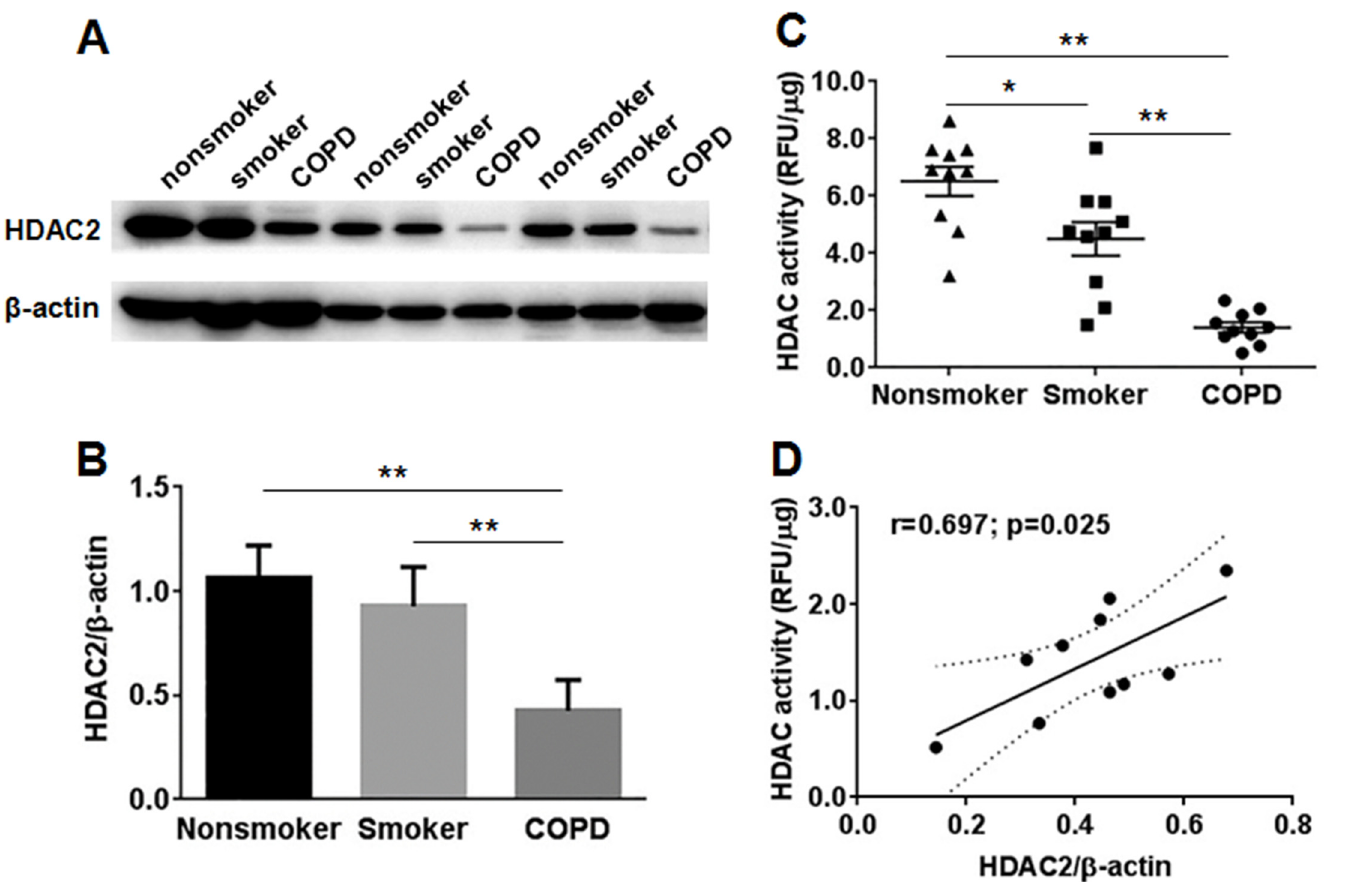
Fig 1. HDAC2 expression and HDAC activity in PBMCs of COPD patients, smokers, and nonsmokers. (A) The HDAC2 protein expression was measured by Western blot in nuclear extracts of PBMCs. β -actin was assessed as a loading control. (B) The relative intensity of HDAC2 was calculated by densitometry. (C) Total HDAC activity in nuclear extracts in PBMCs was measured. (D) Correlation between HDAC2 expression and HDAC activity in nuclear extracts of PBMCs in COPD patients. Data are presented as mean ± SEM. * P < .05, ** P < .01. RFU relative fluorescence units.